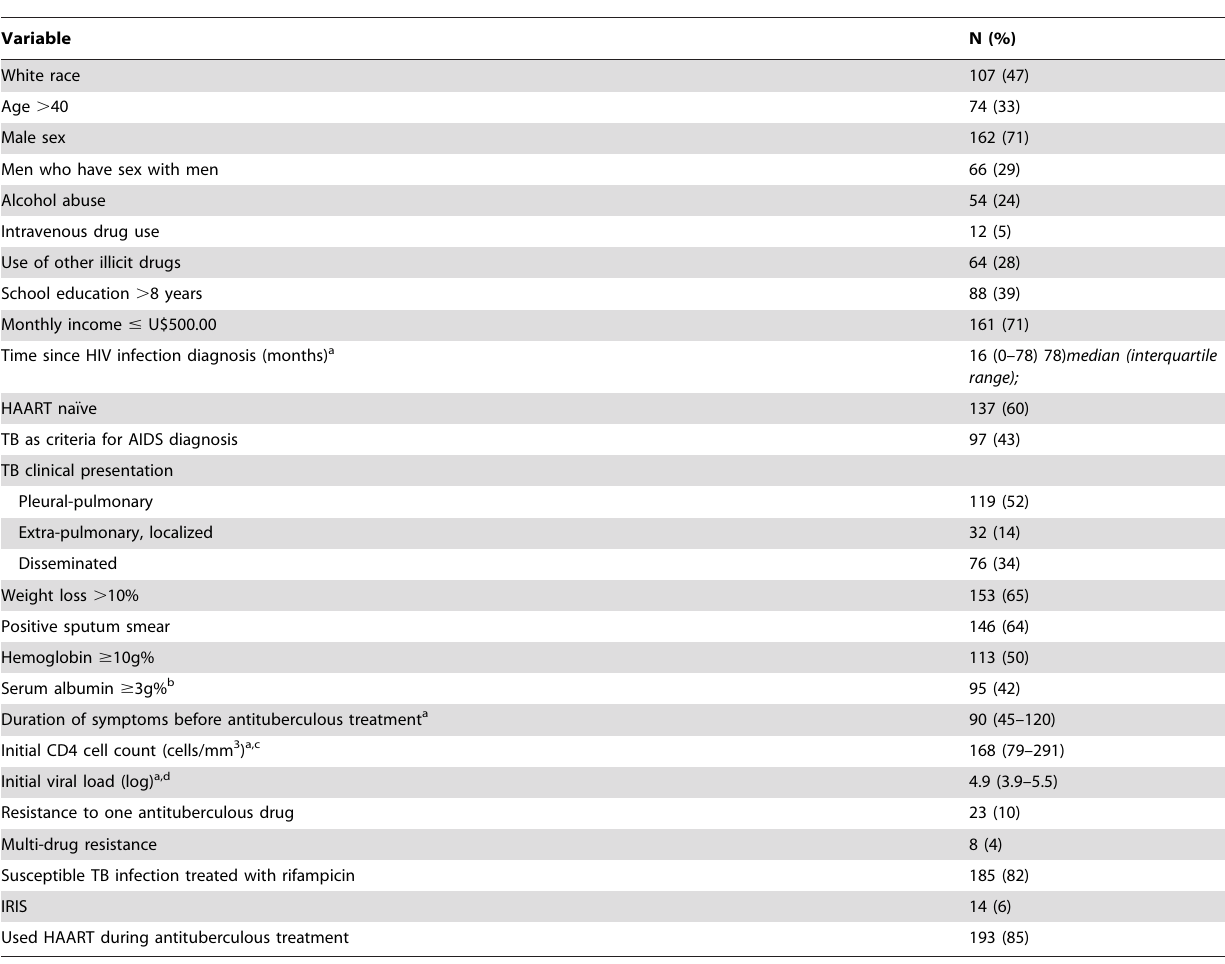
Table 1. Distribution of Baseline and Follow-up